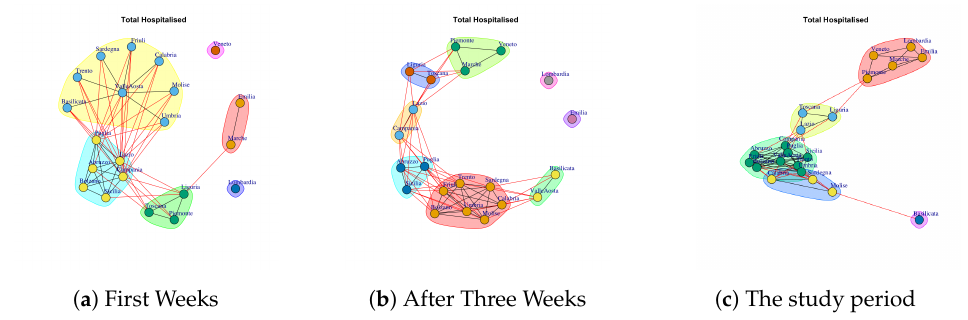
Figure 16. Evolution of Total Hospitalized Network